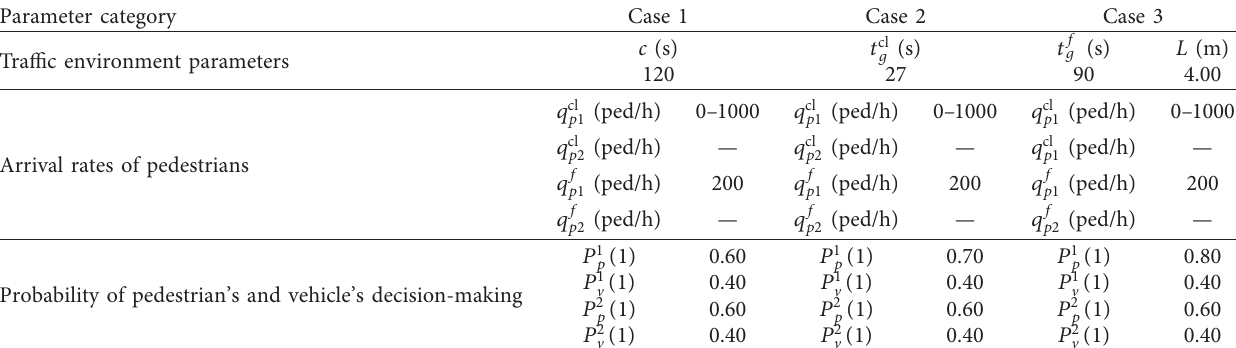
Figure 6: Schematic diagram of the cellular automata model for motor vehicles and pedestrians. Table 7: Parameters in microscopic